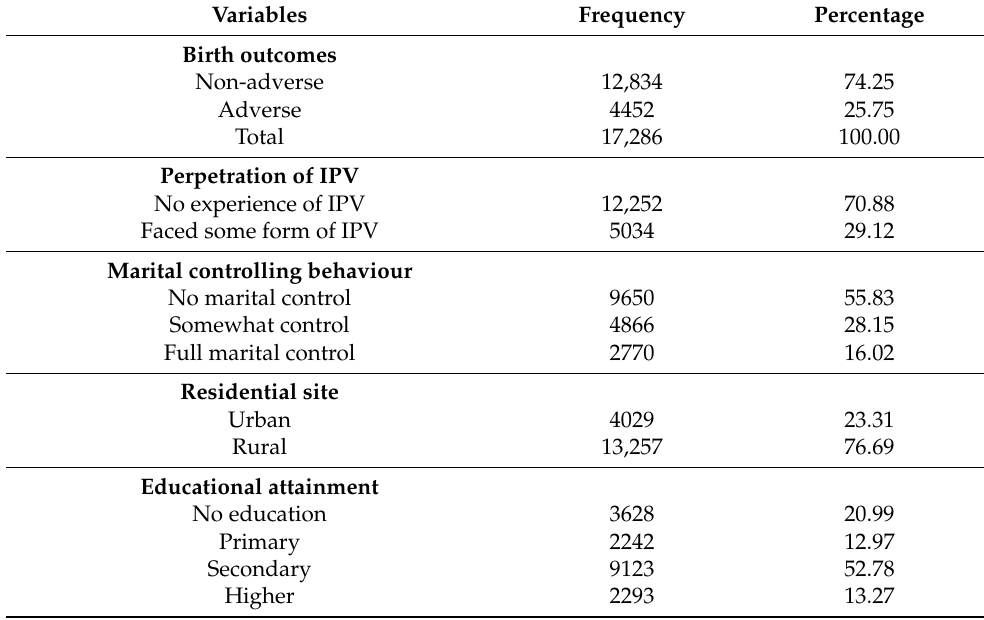
Table 1. Summary statistics of variables studied.